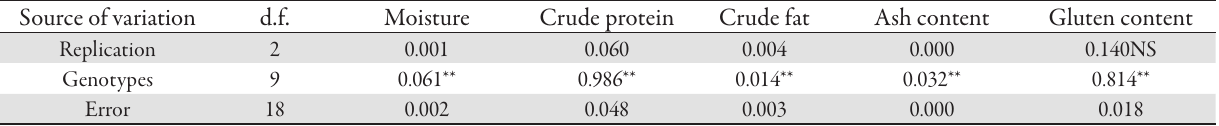
Tab. 2. Analysis of variance of quality traits in ten wheat genotypes under normal irrigation conditions Source of variation